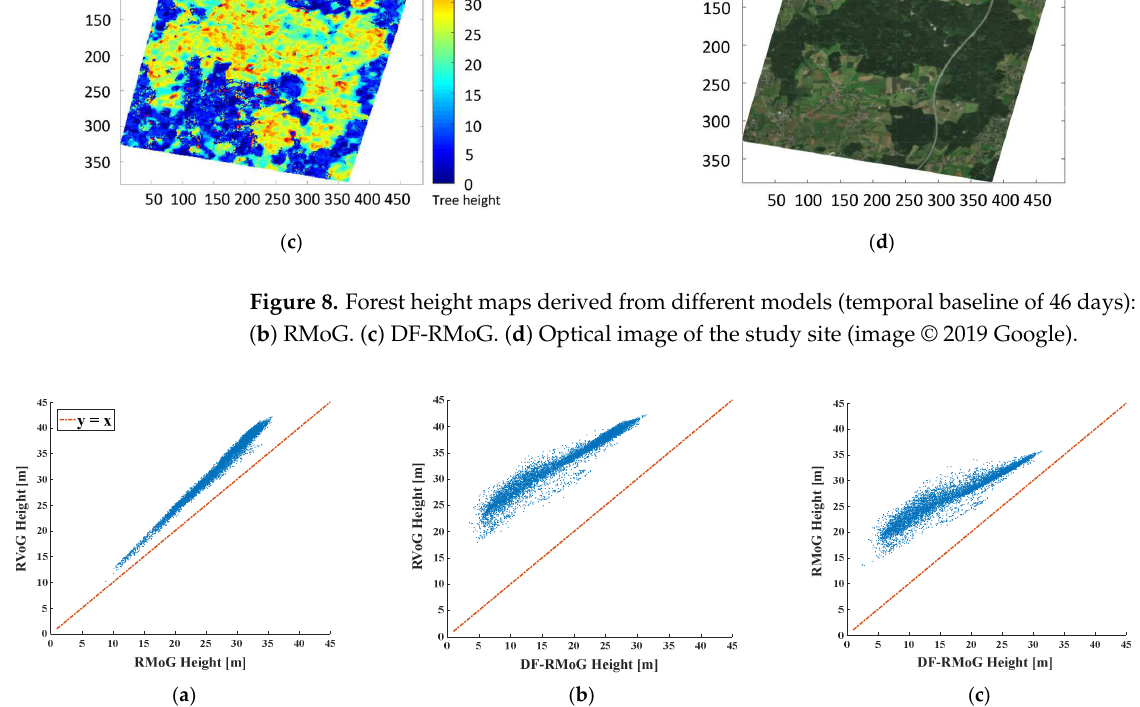
Figure 9. Scatter plots showing the comparison of three models (temporal baseline of 46 days): ( a ) RVoG vs. RMoG. ( b ) RVoG vs. DF-RMoG. ( c ) RMoG vs. DF-RMoG.